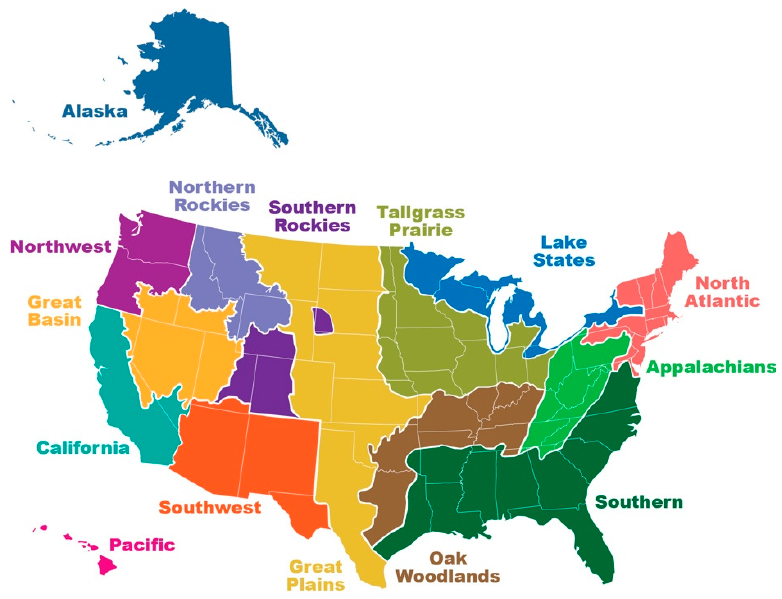
Figure 1. Map of JFSP Fire Science Exchange Network and location of the 15 regional Fire Science Exchanges.